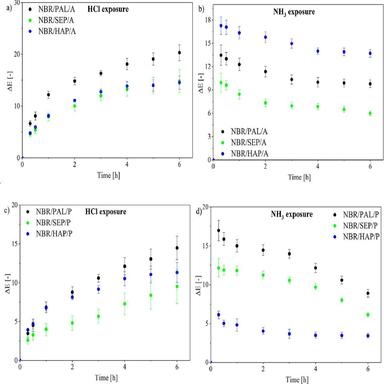
Total color change parameters (DE) for the NBR composites filled with (a,b) alizarin pigments and (c,d) purpurin pigments at different exposure times to vapors.